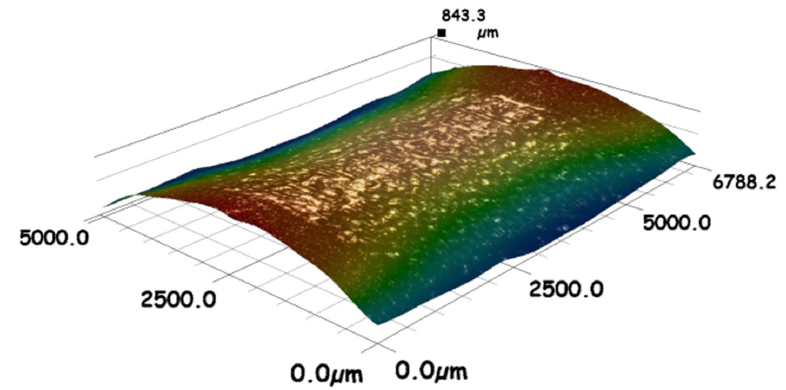
Figure 4. Three-dimensional (3D) microscope image of 316L SST AM sample after CO 2 laser polishing with 110 W, 20% percentage overlapping laser scans (OV), 20 rpm, and laser beam focused on the surface.